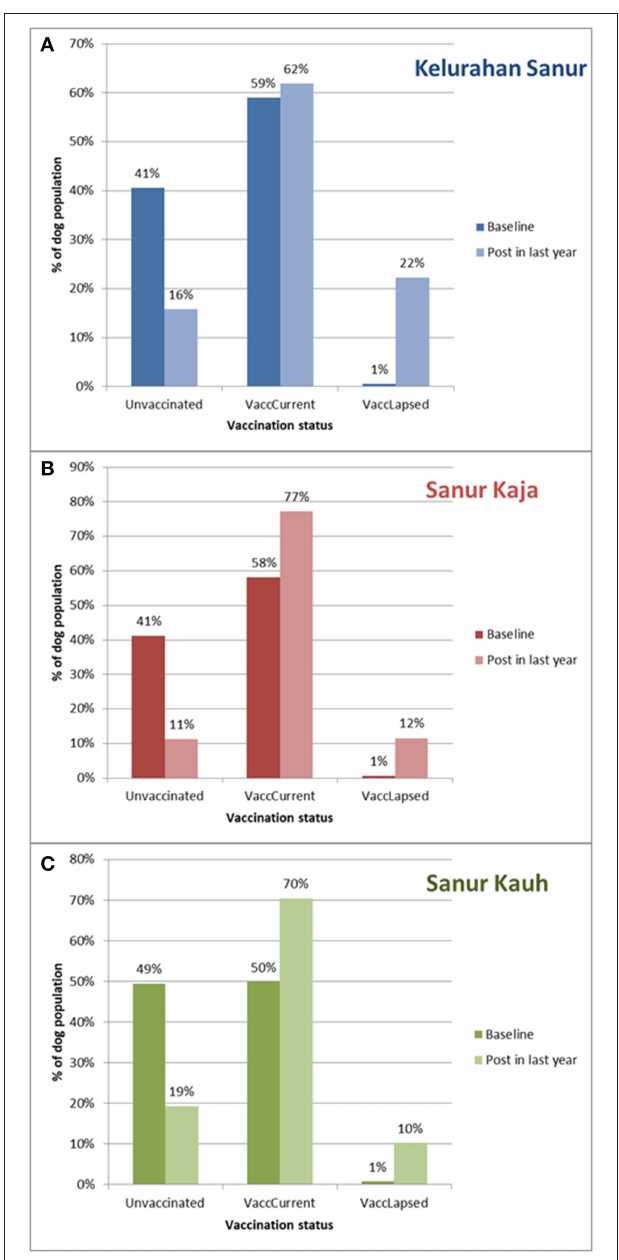
an average 23.6% reduction per year, equivalent to a reduction of 0.51 dogs per km of street surveyed in the first year ( F = 1.896, d.f. = 8, p = 0.0339); and in Sanur Kauh an average